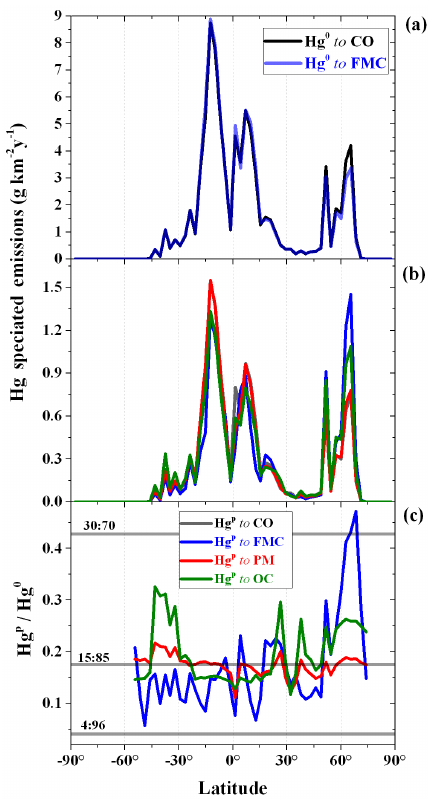
Figure 4. Latitudinal profiles of (a) Hg 0 emissions when mapped ( g ) to CO and when speciation is determined by FMC; (b) Hg P emis- sions when mapped to CO, PM and OC and when speciation is driven by FMC; and (c) the relevant ratio Hg P :Hg 0 . For both ( g ) Hg 0 and Hg P emissions mapped to CO, only the speciation ( g ) emissions (15:85 Hg P :Hg 0 ) is reported for clarity, whereas in (c) all the ( g ) ( g ) speciations are ) ( g )